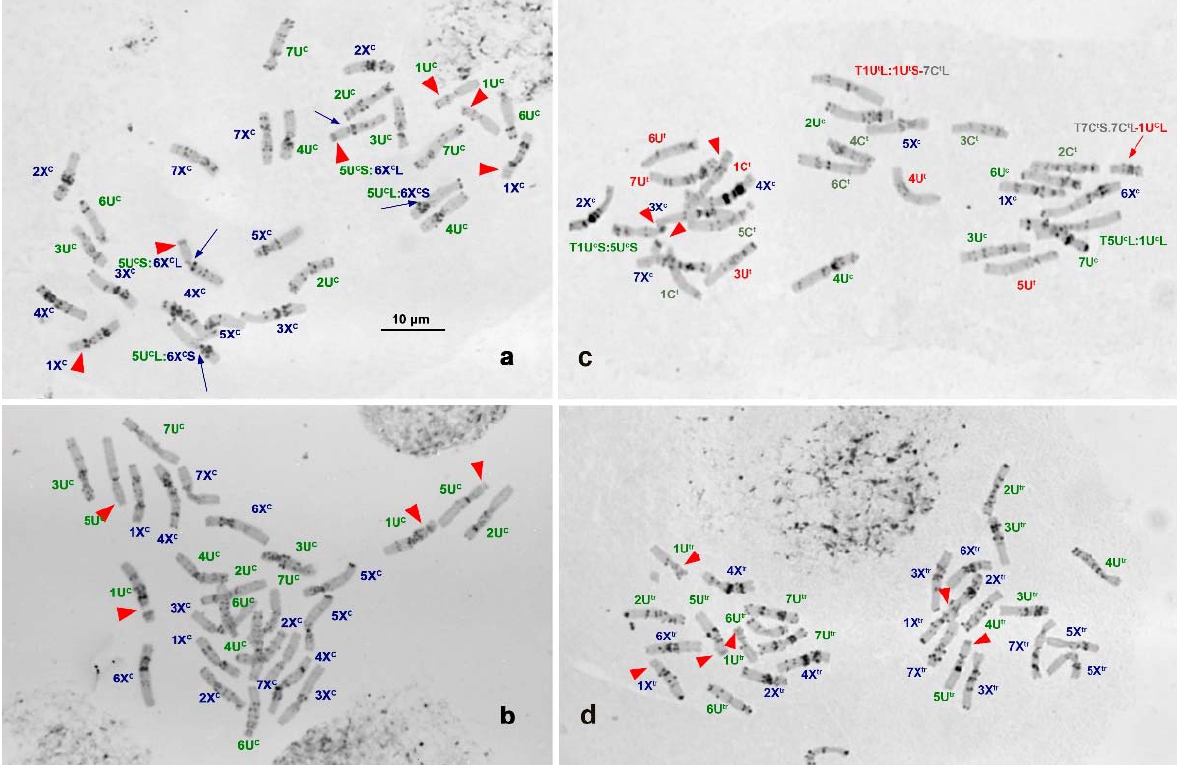
Figure 1. C-banded metaphase cells of accessions representing two karyotypic groups of Ae. columnaris ( a – c ) in comparison with Ae. neglecta ( d ): ( a ) — IG 48818 (C-I); ( b ) — PI 564180 (C-II), ( c ) — the F 1 hybrid of Ae. columnaris (K − 4224) × Ae. triuncialis (genotype unknown) carrying reciprocal translocations 1U c :5U c derived from Ae. columnaris and 1U t :7C t derived from Ae. triuncialis ; ( d ) —Ae. neglecta (K − 4553). Chromosomes are designated according to genetic nomenclature; the U c /U tr chromosomes are labeled in dark green, the X c /X tr chromosomes in dark blue, the C t of Ae. triuncialis— in red, and the U t in grey color). Red arrowheads point to satellite chromosomes. Blue arrows show translocated 5U c :6X c chromosomes ( a ).